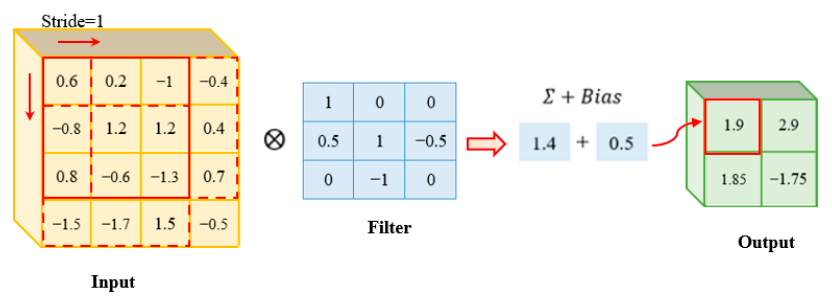
Figure 10. Convolutional layer.